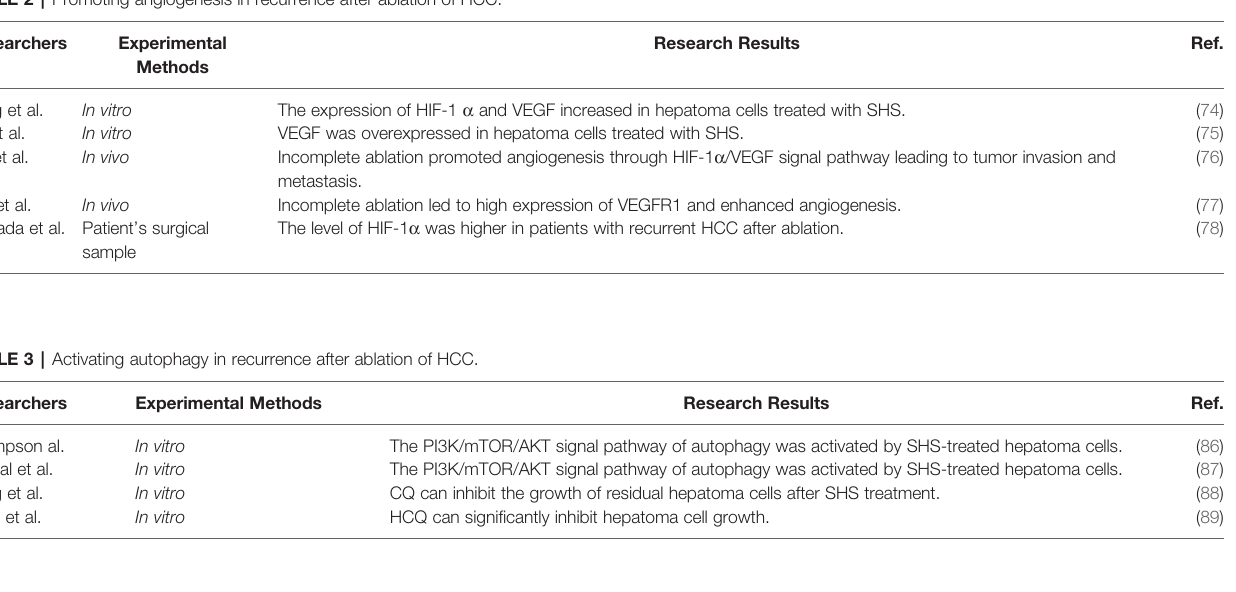
TABLE 2 | Promoting angiogenesis in recurrence after ablation of